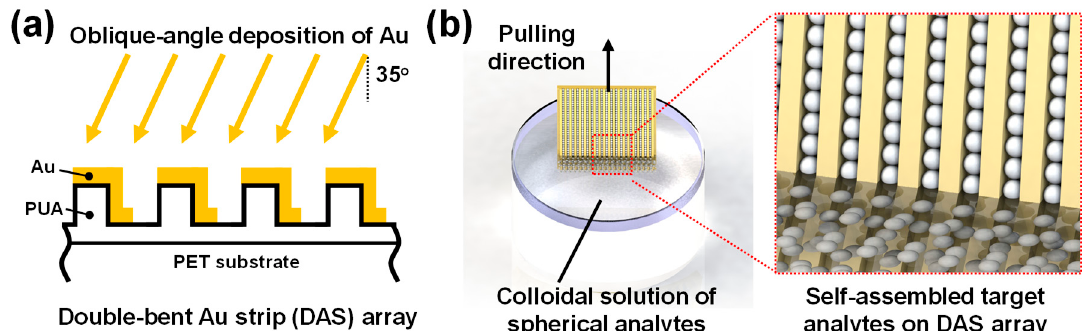
Figure 1. Schematic illustration of sample preparation. ( a ) Double-bent Au strips (DAS) were thermally deposited at an oblique angle on UV-imprinted polymer nanograting structures. PUA and PET are polyurethane acrylate and polyethylene terephthalate, respectively. ( b ) A dip-coating process was used to assemble polystyrene beads or exosomes on the DAS sensors; the dip-coating process was repeated to accumulate